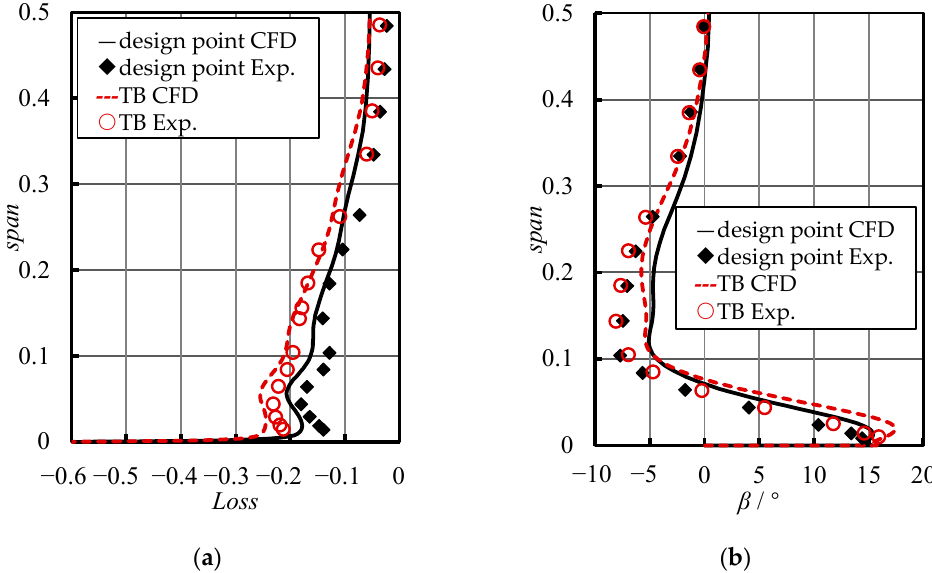
Figure 7. The experimental and CFD results of the pitch-averaged performance at 40% C a downstream of the TE at i = − 1°. ( a ) Total pressure loss coefficient; ( b ) Outflow angle.